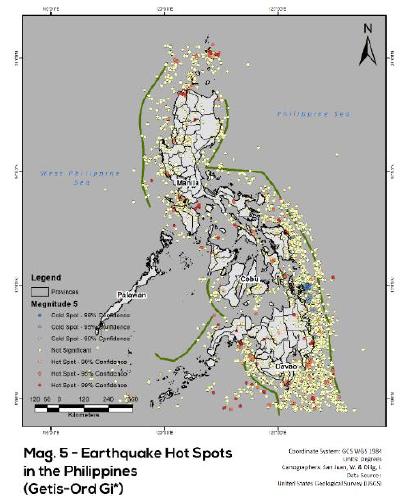
Figure 7. Mag.5-Earthquake Hot Spots in the Philippines from 1975 to 2019